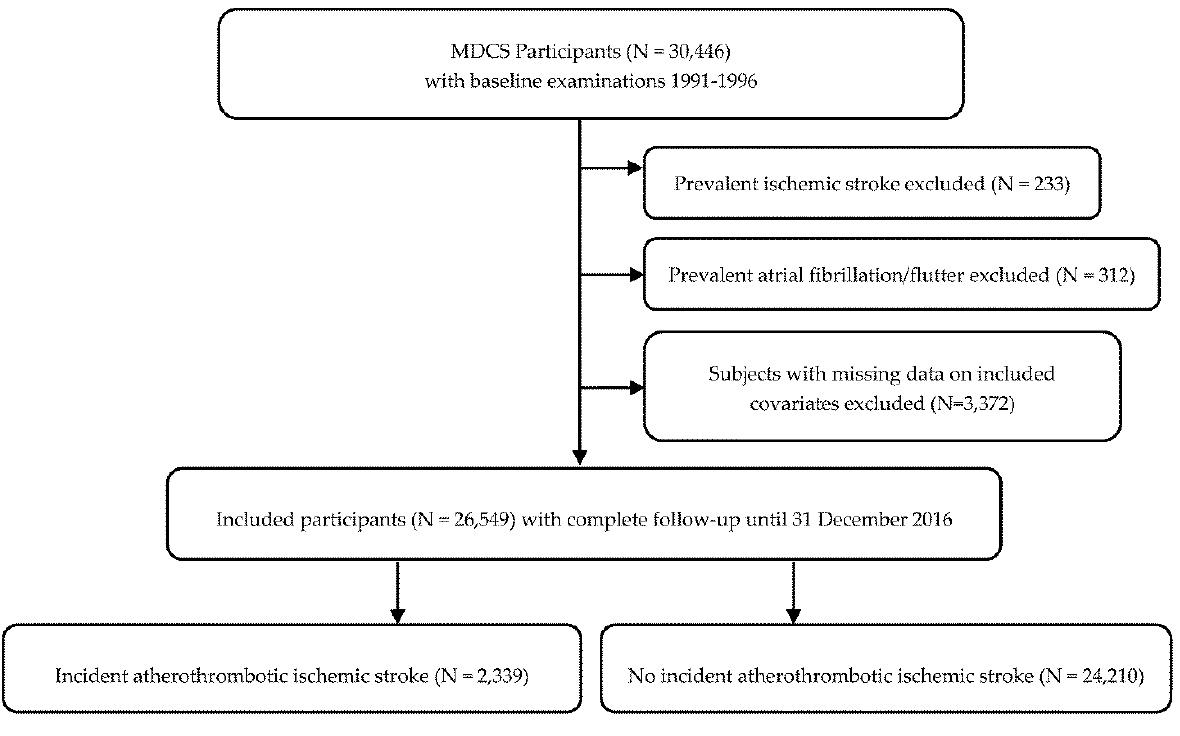
Figure 1. Descriptive flow diagram of study participants and exclusions. Some individuals had multiple exclusion criteria.